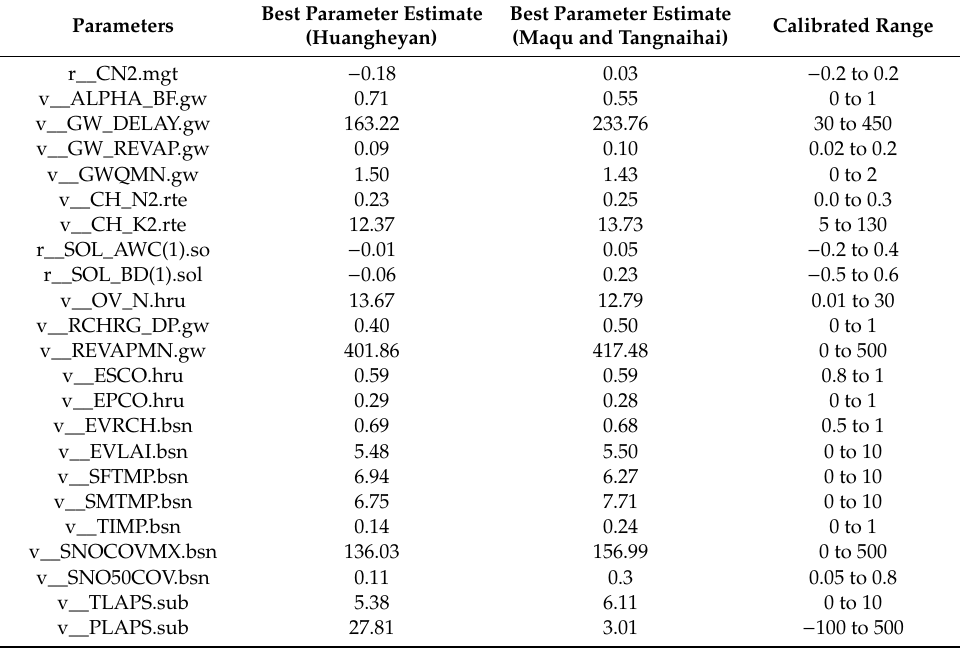
Table 2. Best parameter range for the selected 23 most sensitive parameters in SWAT model hydrological simulations. Parameters beginning with “v__” and “r__” indicate a replacement and a relative change to the initial parameter values, respectively. Best Parameter Estimate